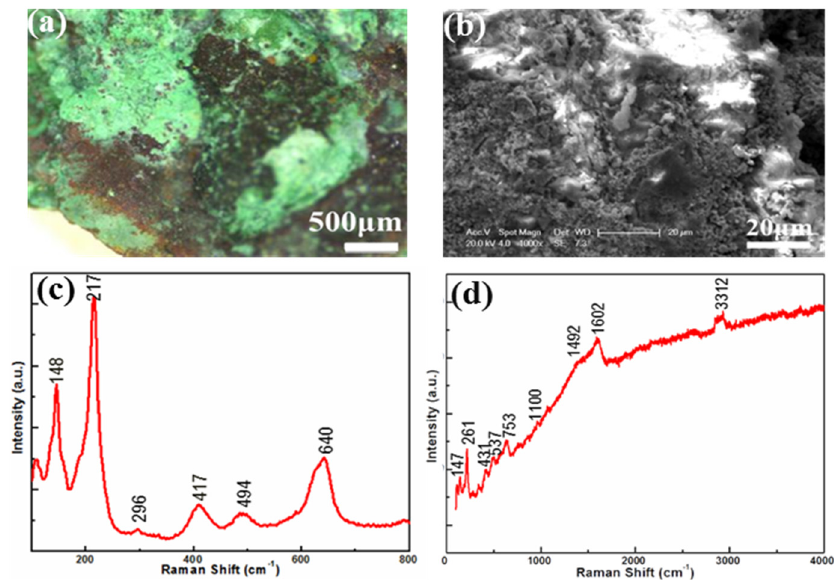
Figure 3. Characterizations of the corrosion products upon the bronze goblet ( Jue Bei ) (Shang Dynasty, collection No.: 3253): ( a ) Optical image; ( b ) SEM morphology; ( c ) Raman spectrum of the red corrosion product (cuprite) in a range 100–1000 cm − 1 ; ( d ) Raman spectrum of the light green corrosion product (malachite) in a range 100–3500 cm − 1